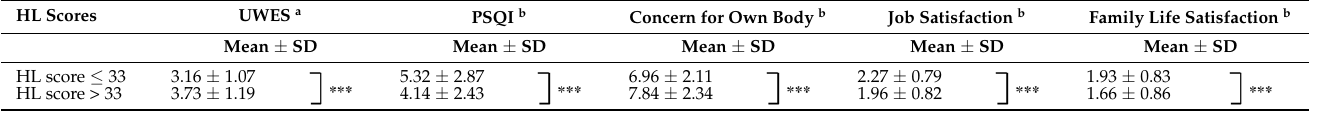
Table 5. Impacts of health literacy on other variables among three companies.